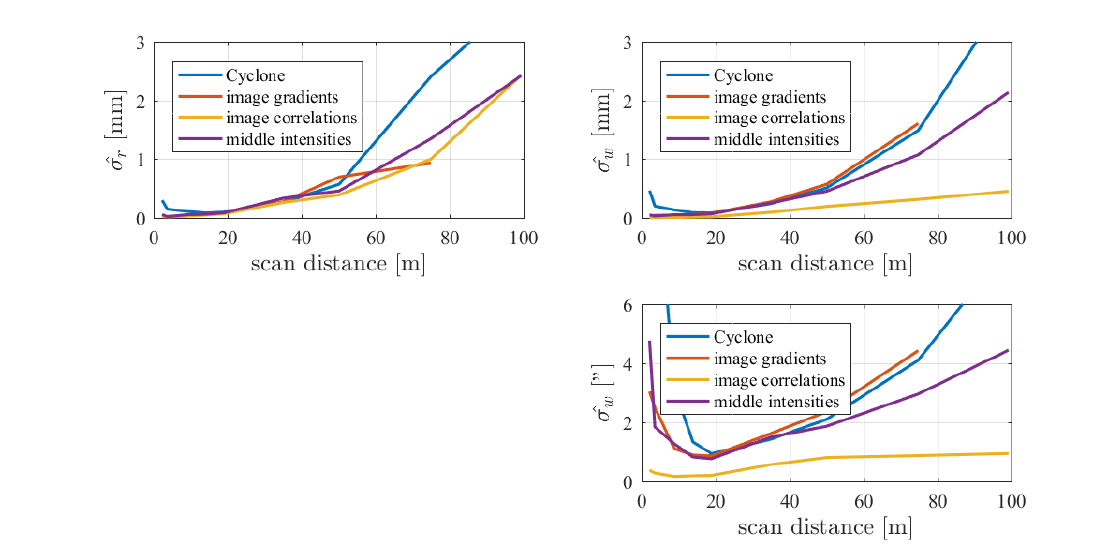
Figure 6. Empirical standard deviations in distance direction ˆ σ r and angular direction ˆ σ w for each algorithm depending on the